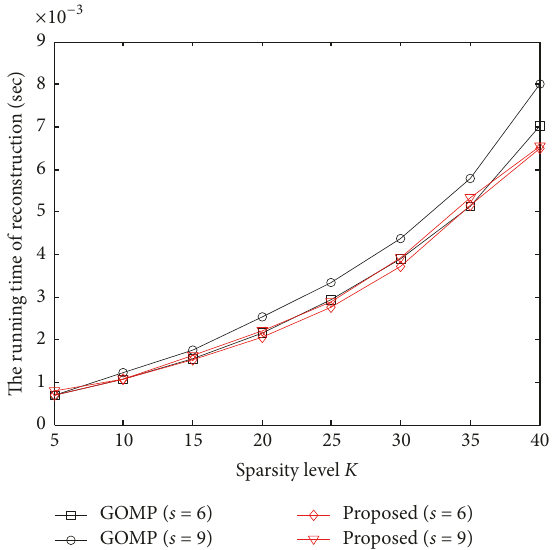
Figure 4: The average running time of GOMP and the proposed method with a small 𝑆 value.